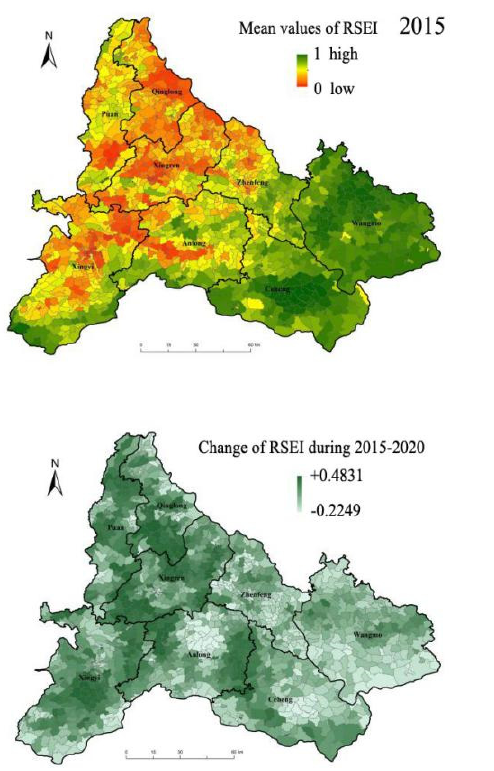
12 of 20 Figure 6. Scatter diagram.